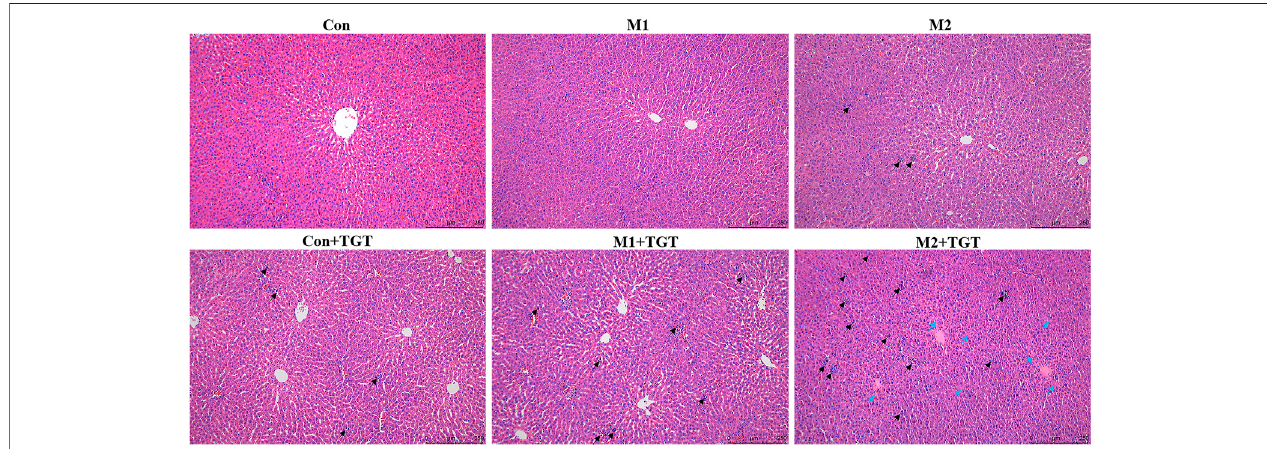
FIGURE4| RepresentativepicturesofHEstainingofthelivertissuesinthenormalandtwotypesofadriamycin-induced-NSratsassignedtothree reference(Con, M1, M2), and three TGT treatment (Con + TGT, M1+TGT, and M2+TGT) groups after TGT oral gavage dose of 10 mg/kg/day for 4 weeks, in fl ammatory cell in fi ltration (black arrow b ), degeneration of hepatocytes (blue arrow ) (magni fi cation: ×100).